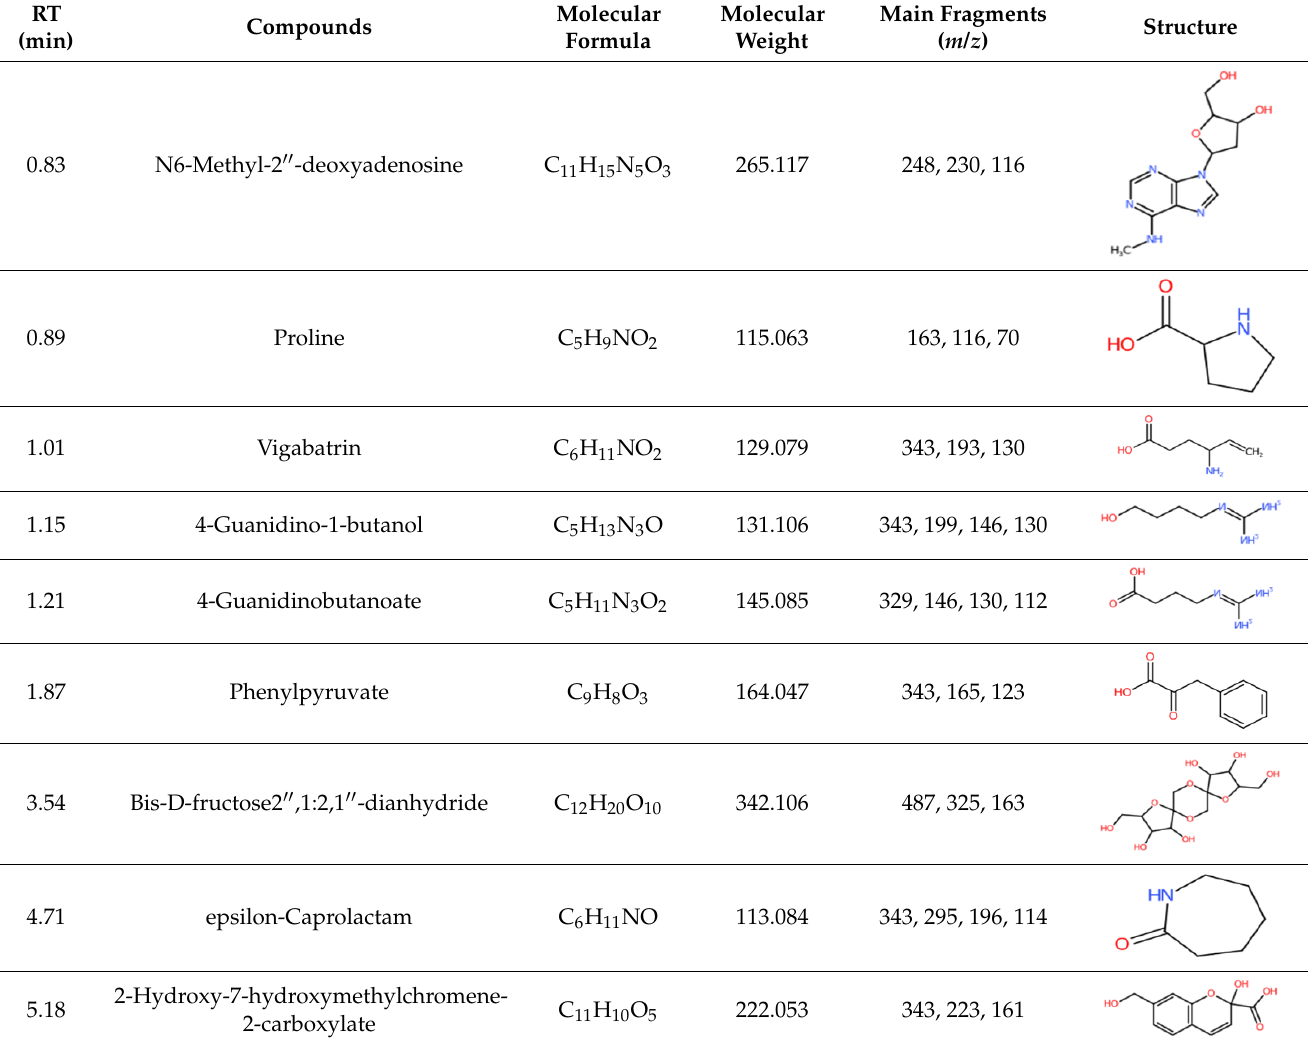
Table 1. Mass spectrometric data of key compounds found in the extract of w VM.